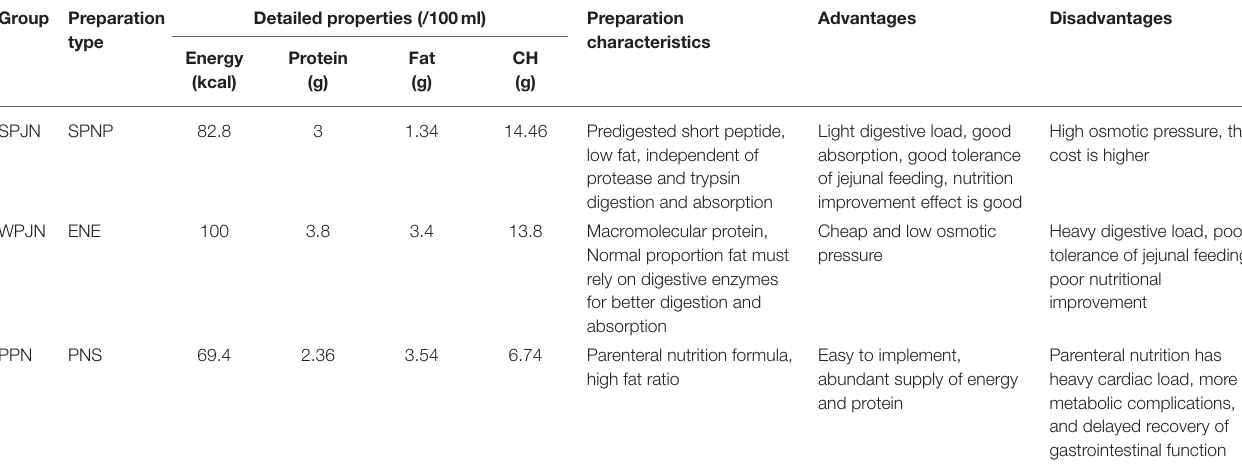
TABLE 1 | The detailed properties, characteristics and primary advantages and disadvantages of three